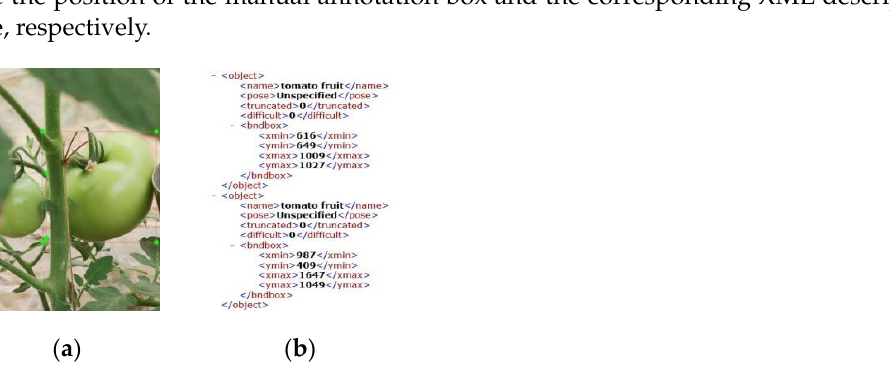
Figure 1. Annotation of tomato young fruits image. ( a ) annotated image. ( b ) XML document.